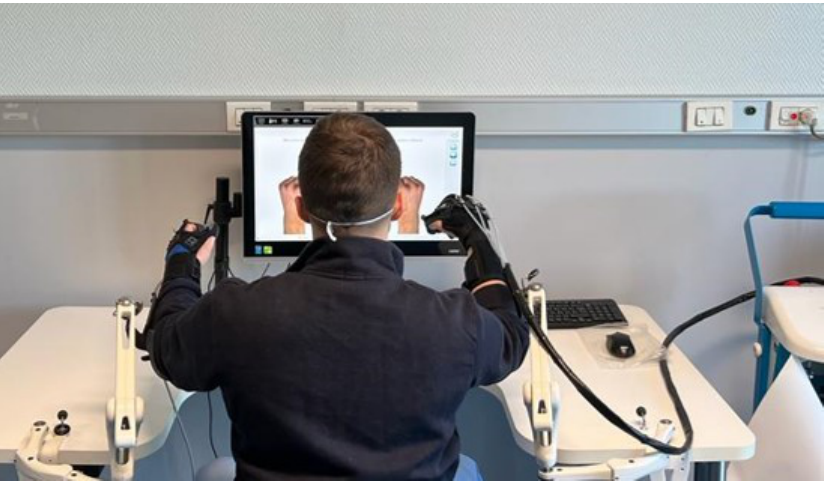
Figure 4. The Gloreha Sinfonia, the robotic exoskeleton for the neuro-rehabilitation of the